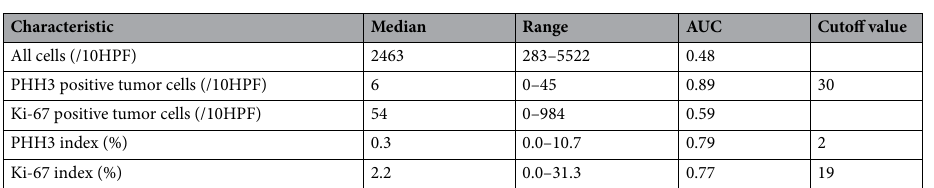
Table 2. Pathological characteristics of surgical specimens and cutoff values from ROC curves. PHH3 Phosphohistone H3, HPF High power fields, AUC Area under the curve, ROC Receiver operating characteristic.